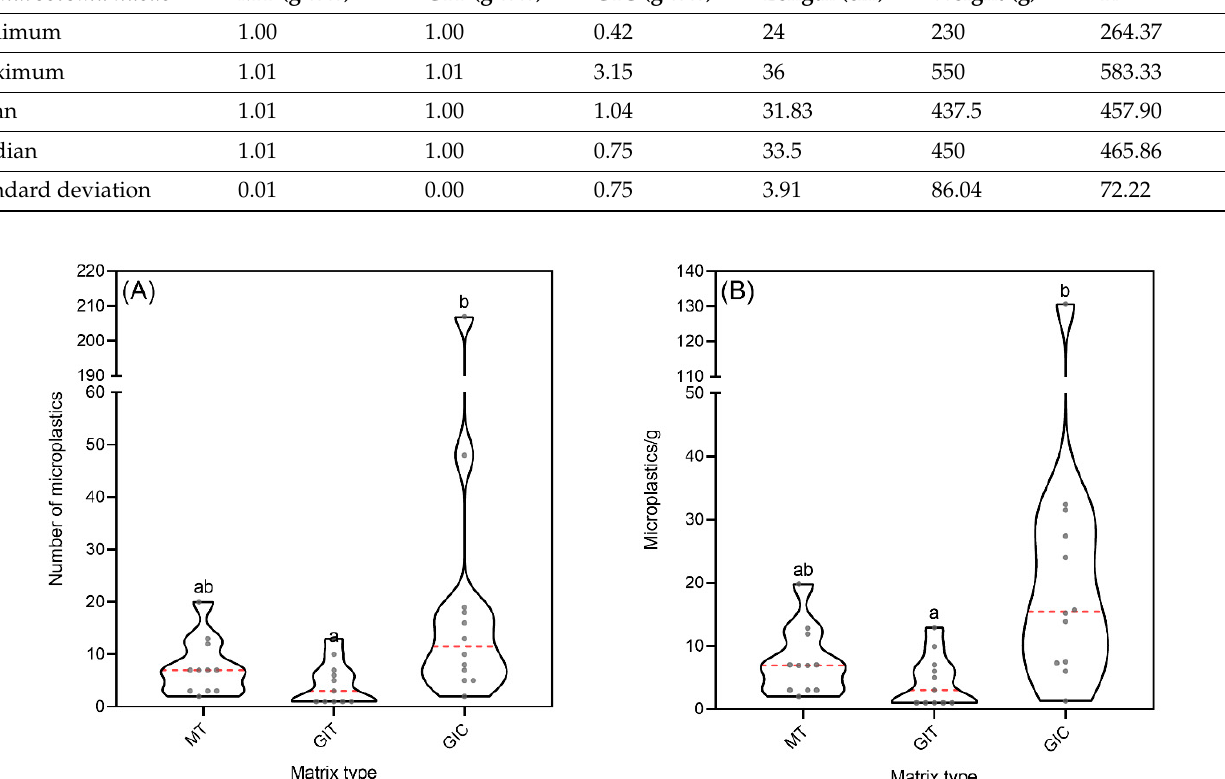
Figure 1. Violin plots of microplastics in common nase individuals. ( A )—total number of microplastics. ( B )—microplastics based on the analyzed matrix weight. The red dotted line represents the median, the staggered dots are the data points, and the letters above the groups denote statistically significant differences ( p < 0.05); gastrointestinal tissue (GIT), the gastrointestinal content (GIC) and muscle tissue (MT).